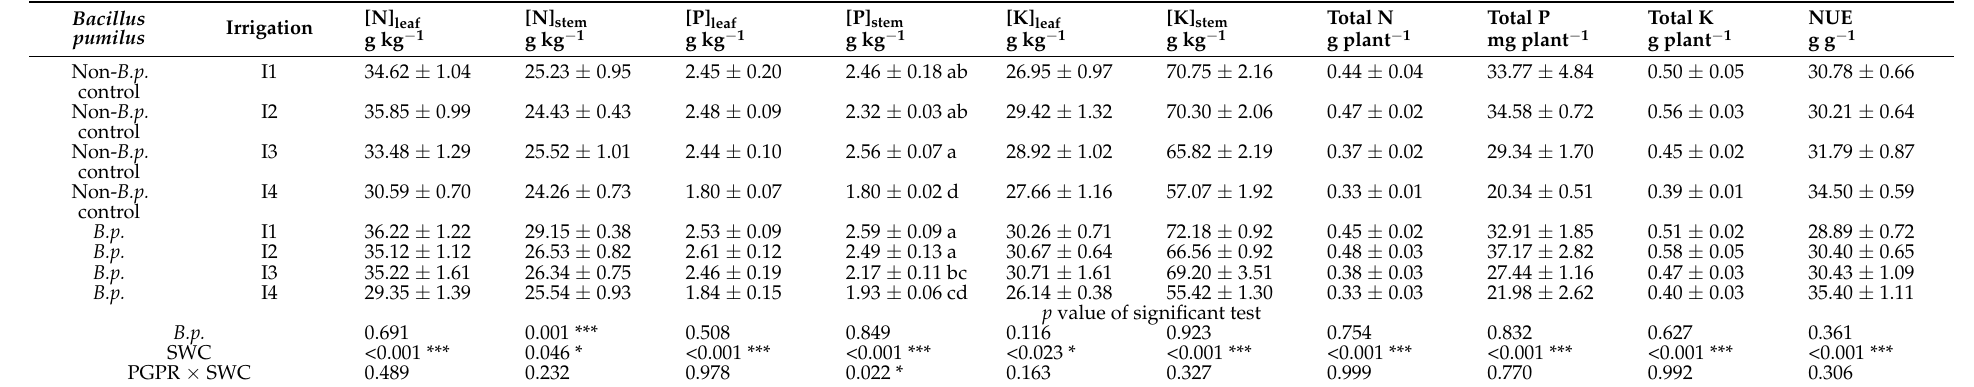
Table 3. The effect of Bacillus pumilus ( B.p. ) inoculation on the contents of nitrogen (N), phosphorus (P), and potassium (K) in leaf and stem, and total uptake of N, P, K, and nitrogen use efficiency (NUE) under four irrigation